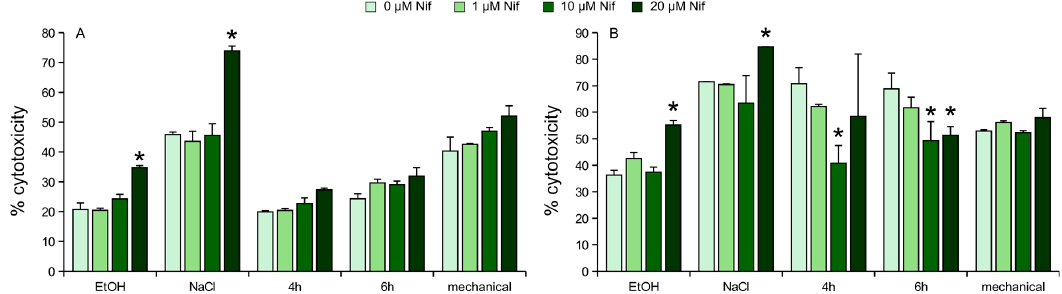
Figure 2. LDH activity measurement after stress on nifedipine pre-treated Neuro2a cells. ( A ) Undifferentiated Neuro2a; ( B ) differentiated Neuro2a. Values are given as the mean ± SD (error bars) of one representative out of at least three biologically independent experiments. Nif = nifedipine; mechanical = mechanical stress; NaCl = osmotic stress (150 mM); EtOH = oxidative stress (2%); 4 h = 4 h heat stress; 6 h = 6 h heat stress; single asterisk = p < 0.05 compared to non-treated cells.